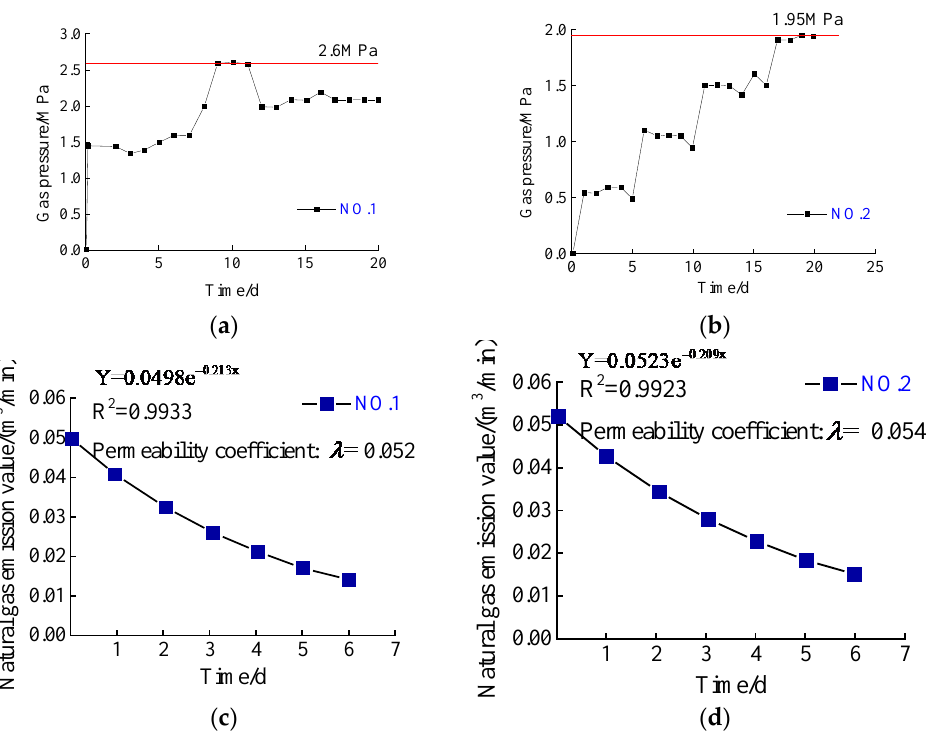
Figure 6. Ding + Wu protects Ji area: ( a ) NO. 1 measuring point gas pressure test data; ( b ) NO. 2 measuring gas pressure point test data; ( c ) NO. 1 measuring point permeability coefficient test data; ( d ) NO. 2 measuring point permeability coefficient test data.